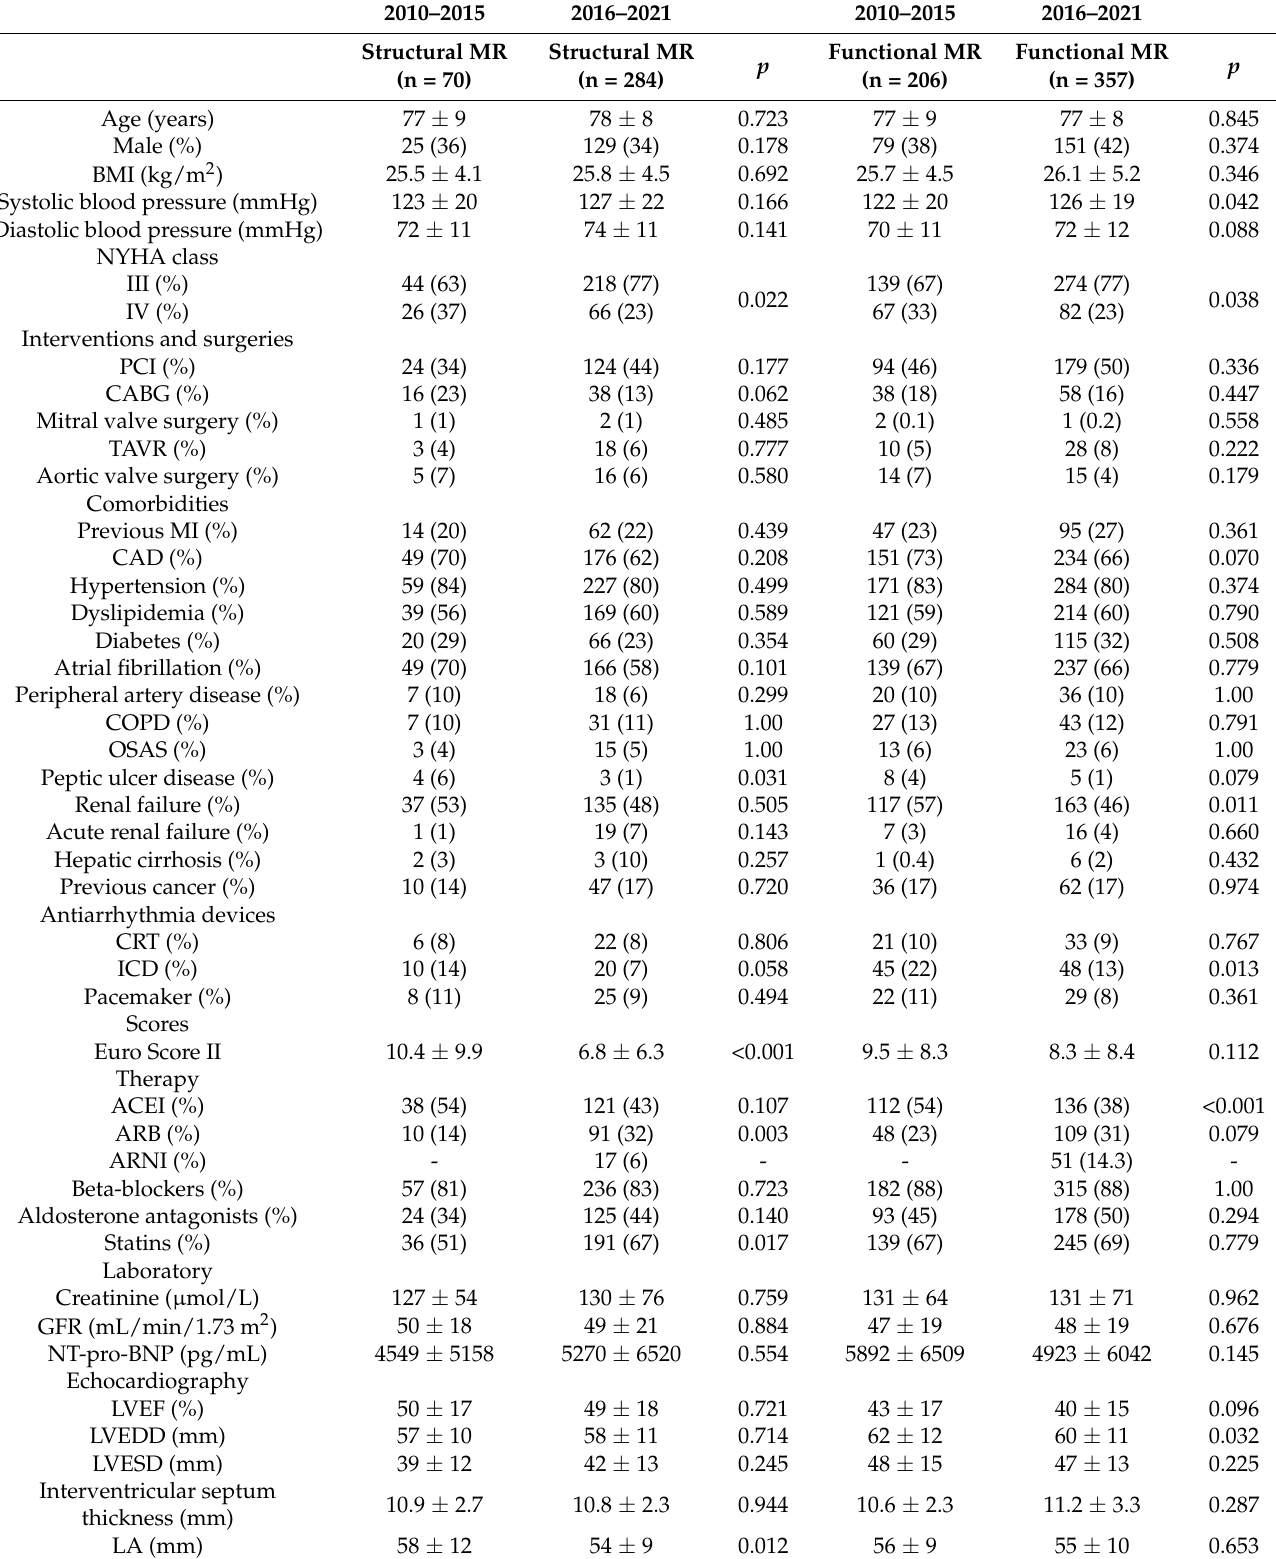
Table 3. Demographic characteristics and clinical parameters in period 2010–2015 and